Question: Summarize what this figure shows in one sentence.
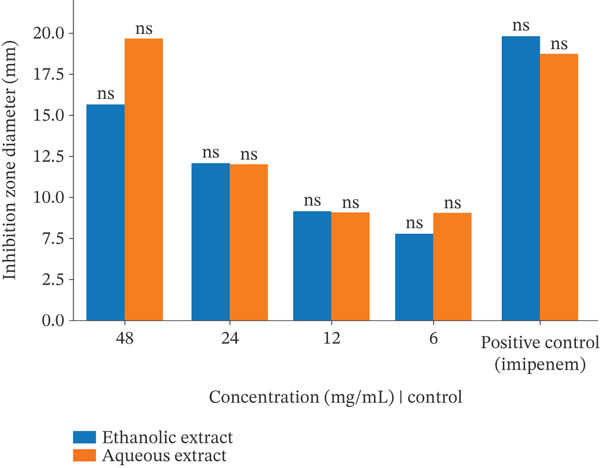
Answer: Antibacterial activity of ethanolic and aqueous extracts of C. ovina against the SS2 isolate evaluated by agar well diffusion assay. Inhibition zone diameters (mm) are shown for extract concentrations of 48, 24, 12, and 6 mg/mL. Imipenem was used as a positive control and 5% DMSO as a negative control. Differences between ethanolic and aqueous extracts at each concentration were not statistically significant (ns).